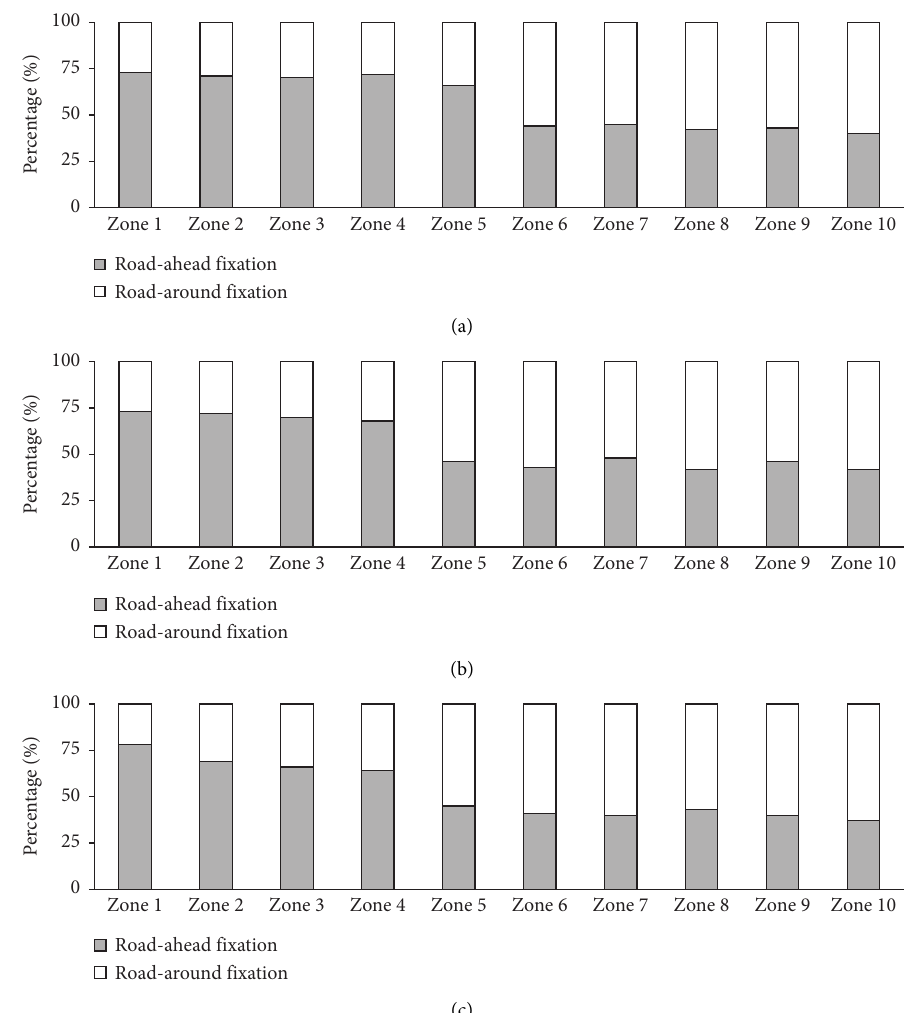
Figure 9: Distribution of drivers’ fixations among different tunnel length conditions. (a) Short-tunnel condition, (b) medium-tunnel condition, and (c) long-tunnel